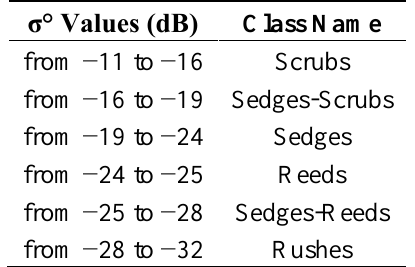
Table 3. Values of σ° and corresponding classes of wetland communities.